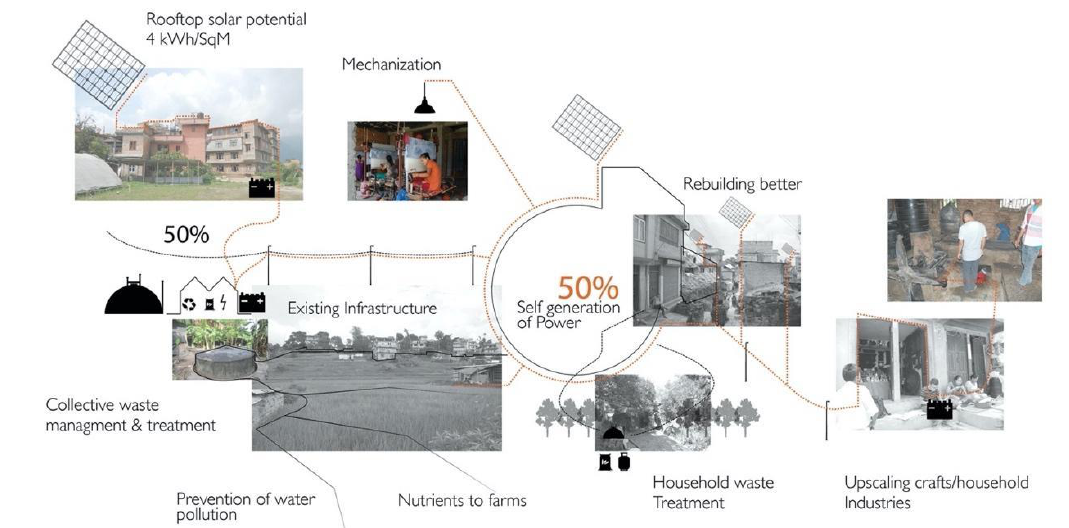
Figure 5. Design Strategy developed around the individual household and scaled up at settlement scale. Source: Author.